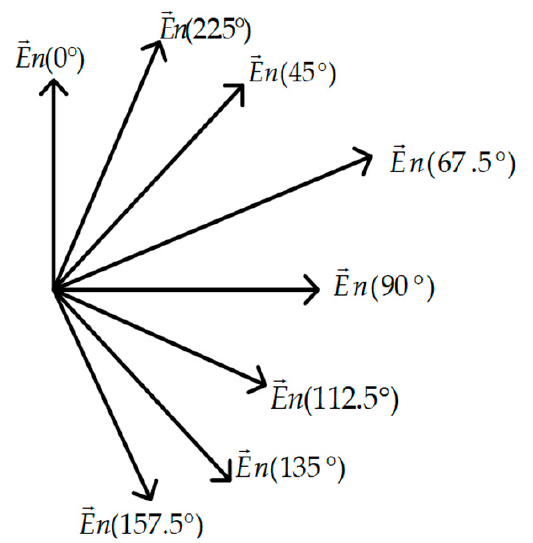
Figure 5. Sketch map of 8 direction vectors. The length of the arrow represents the modulus of vector, and the angle (0°, 22.5°, 45°, 67.5°, 90°, 112.5°, 135°, or 157.5°) represents the angle between the vector and Y axis.